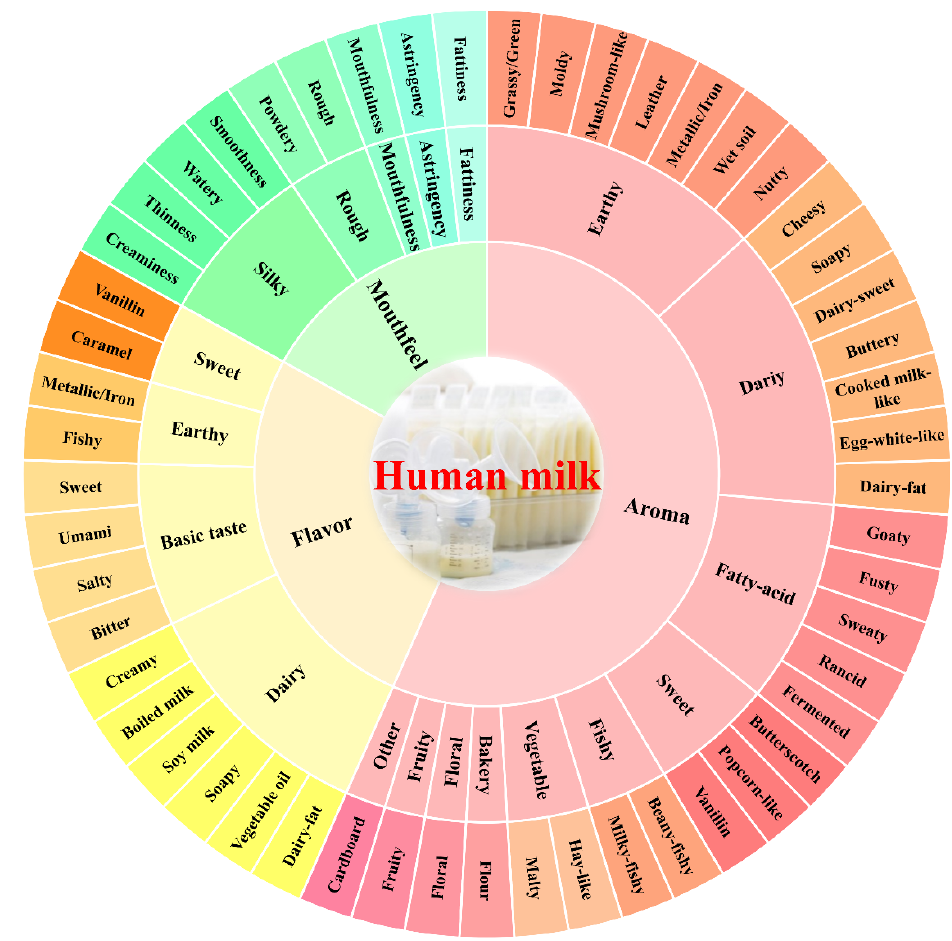
Figure 1. Human milk flavor wheel.